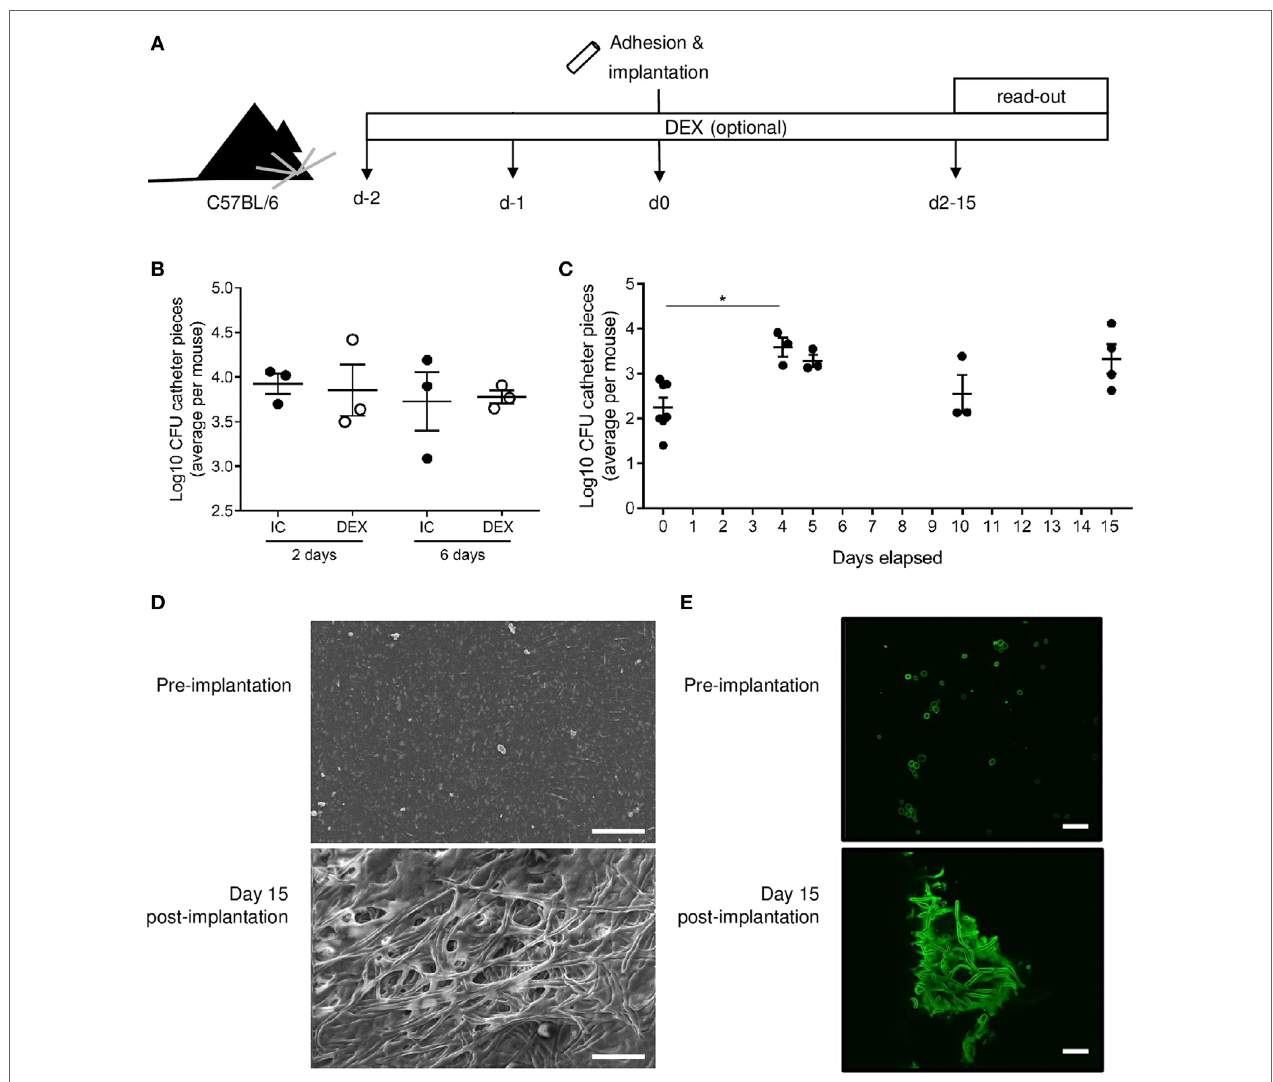
FigUre 2 | Candida albicans biofilms are robustly maintained in C57BL/6 mice without immunosuppression. (A) Catheter pieces were incubated overnight in mouse serum and for 90 min in C. albicans culture at day 0, following by subcutaneous implantation. In the dexamethasone-treated (DEX) group, dexamethasone (1 mg/L) was added in the drinking water from day 2 and maintained over the course of the experiment. Biofilm colony-forming units (CFUs) were read out at indicated days postimplantation. (B) Log 10 of biofilm CFUs compared between immunocompetent (IC) and DEX mice ( n = 3) at 2 and 6 days. Mean ± SEM are shown. (c) Log 10 of biofilm CFUs followed over time ( n = 3–6/group), day 0 = before implantation of catheter pieces. Mean and SEM are shown. One-way ANOVA with multiple comparisons was used for comparison of the different time points (* p < 0.05). (D) Representative scanning electron microscopy images of preimplantation (top), 2 days after implantation (middle), and day 15 after implantation (bottom). (e) Confocal laser scanning microscopy images of catheter pieces before implantation (top) and 15 days postimplantation (bottom). Scale bar = 20